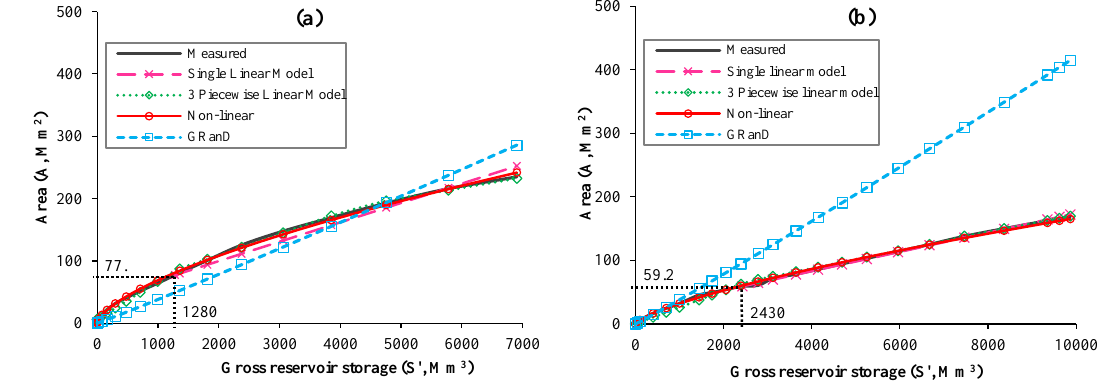
Figure 5. Available and predicted surface areas for the ( a ) Pong and ( b ) Bhakra reservoirs.